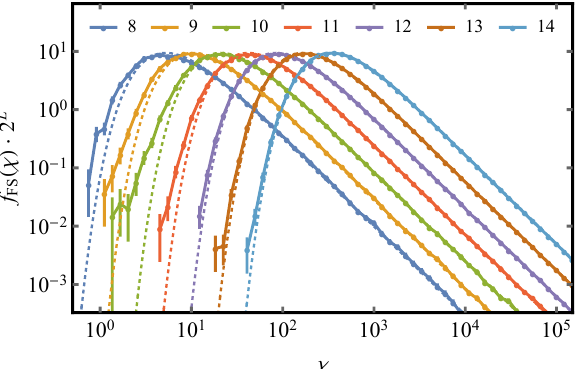
in thermalising quantum systems: Numerically calculated distributions Figure 4: f FS of f in the Spin-ETH model (solid points, colour) are compared with analytic pre- FS dictions for an ETH system (dotted lines, colour). Each numerical distribution was produced by histogramming values of χ α obtained from the mid-spectrum states. Error-bars indicate standard error on the mean. The legend shows the bath sizes L , the other parameters are as in the main text. N = 300 realisations for L = 14, N = 1000